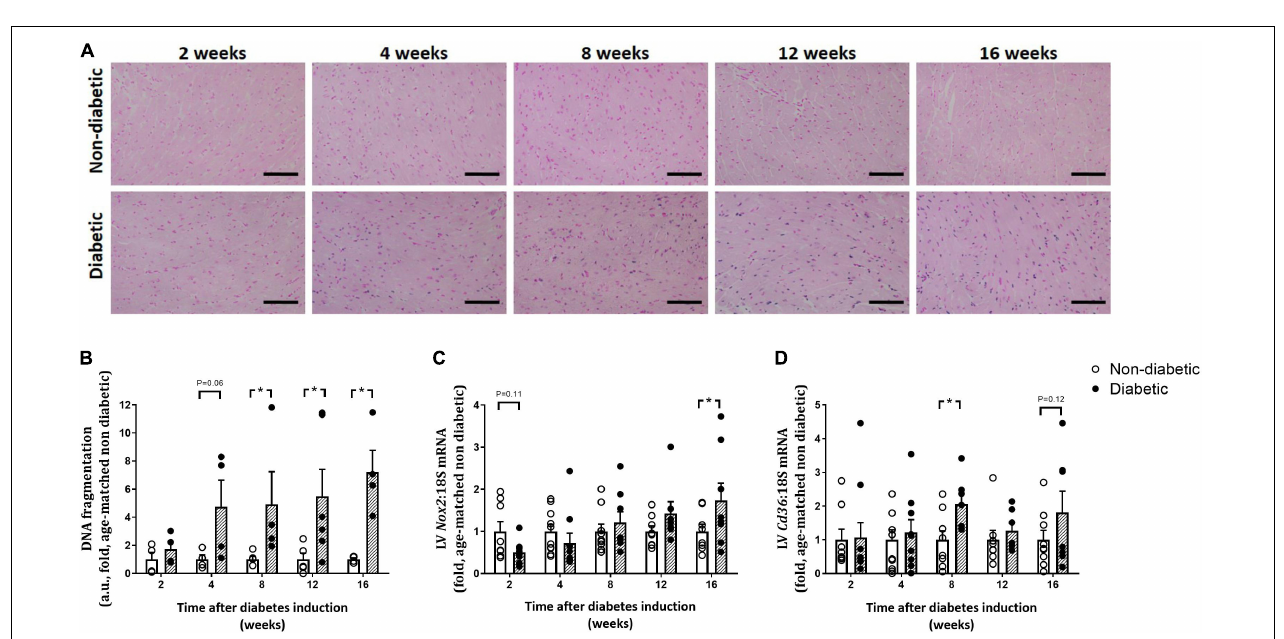
FIGURE 6 | Progression of cardiac fibrosis. Percentage of picrosirius red stained collagen fibers (A,D) and gene expression of Ctgf (B) and Tgf- β (C) increased with the progression of diabetes. Data are presented as mean ± SEM. * P < 0.05 vs age-matched non-diabetic mice (two-way ANOVA with Benjamini and Hochberg post hoc test). Representative images for each endpoint are shown (D) . Scale bar = 40 µ m. n = 7–11/group (refer to Supplementary Figure S1 ).